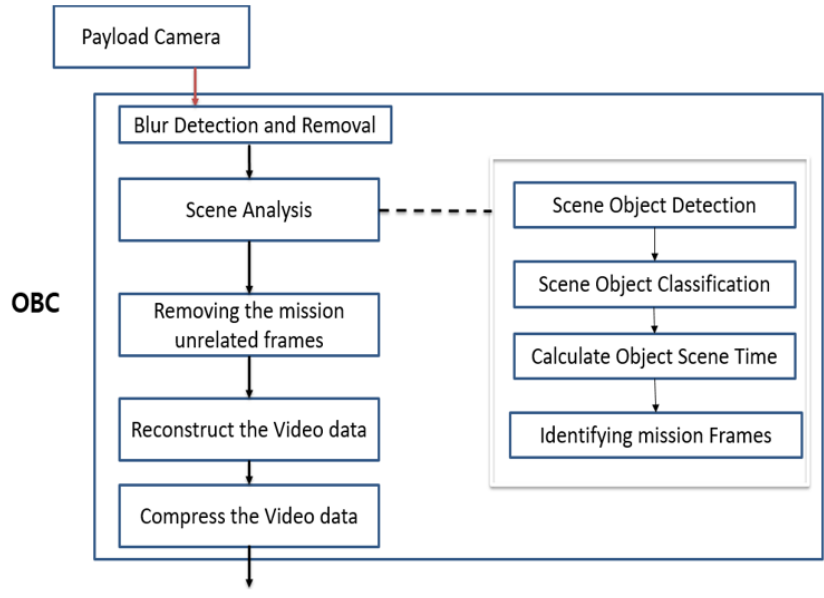
Figure 3. Proposed CNN+LSTM model for video scene analysis.